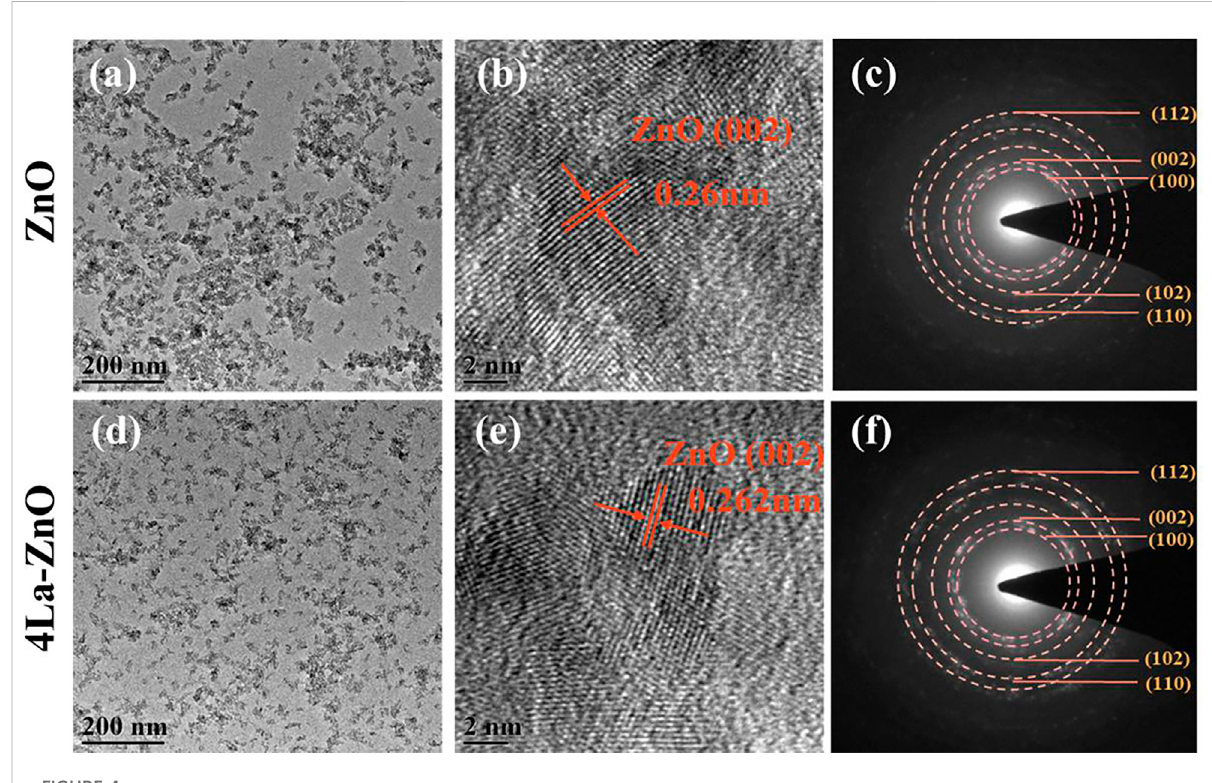
FIGURE 4 TEM (A,D) , HR-TEM (B,E) and SEAD (C,F) patterns of pure and La-ZnO